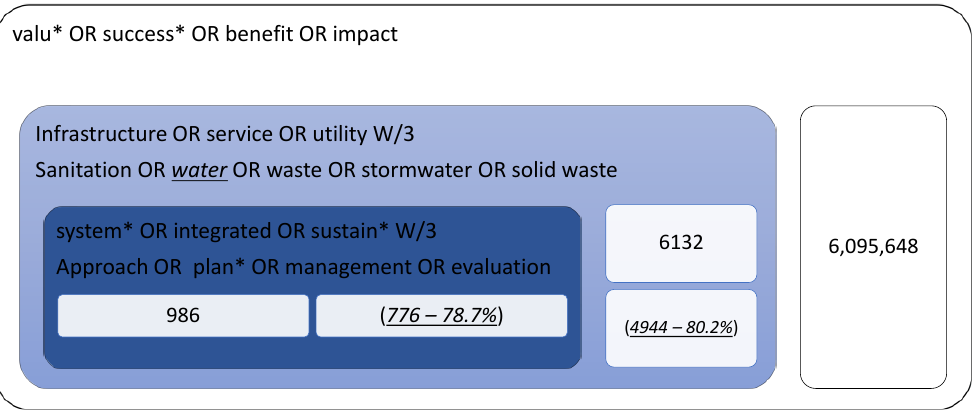
Figure 2. Search results per keyword block, highlighting the results focusing on the word “ water ” .